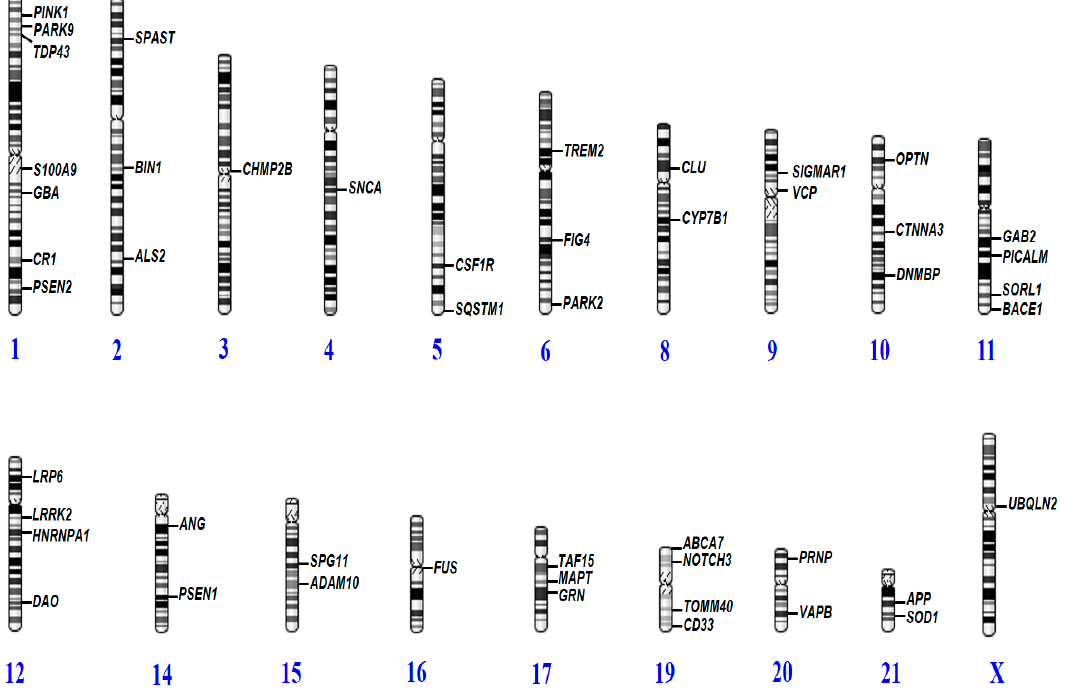
Figure 3. Distribution of neurodegenerative genes in the human genome where causative or probably causative variants were reported to cause early-onset dementia.